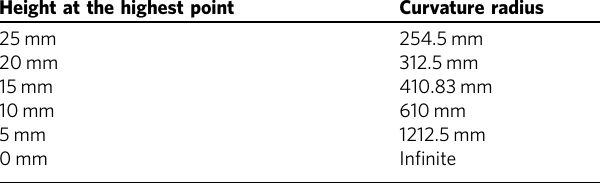
Table 1 Curvature Radius. Height at the highest point